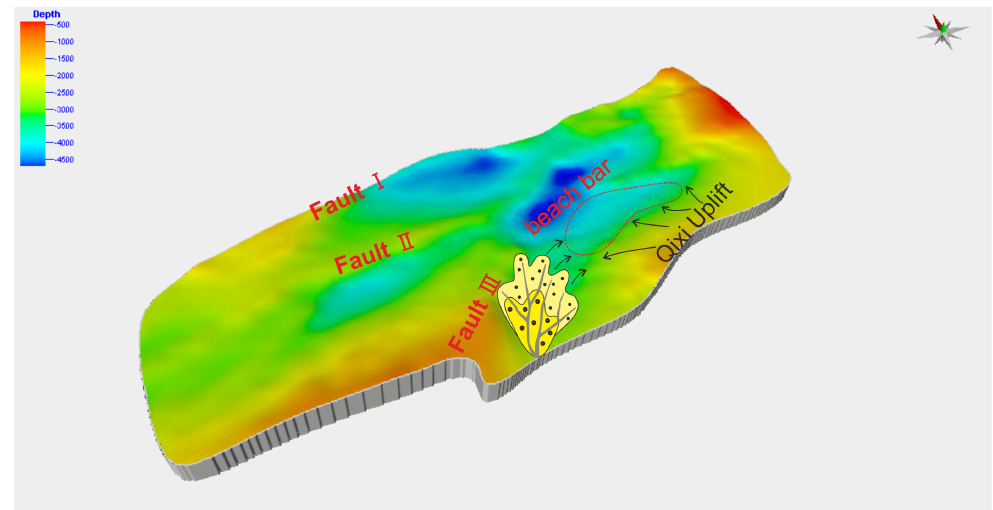
Figure 11. Paleotopography of depositional stage of Mbr2 showing the sediment provenance from the fan deltaic front and the Qixi